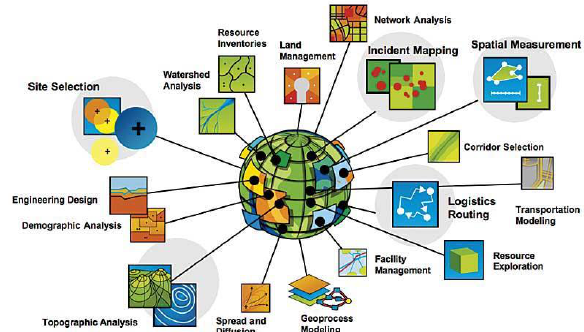
Figure 1: Applied GIS around the world across disciplines, professions and organizations (ESRI,